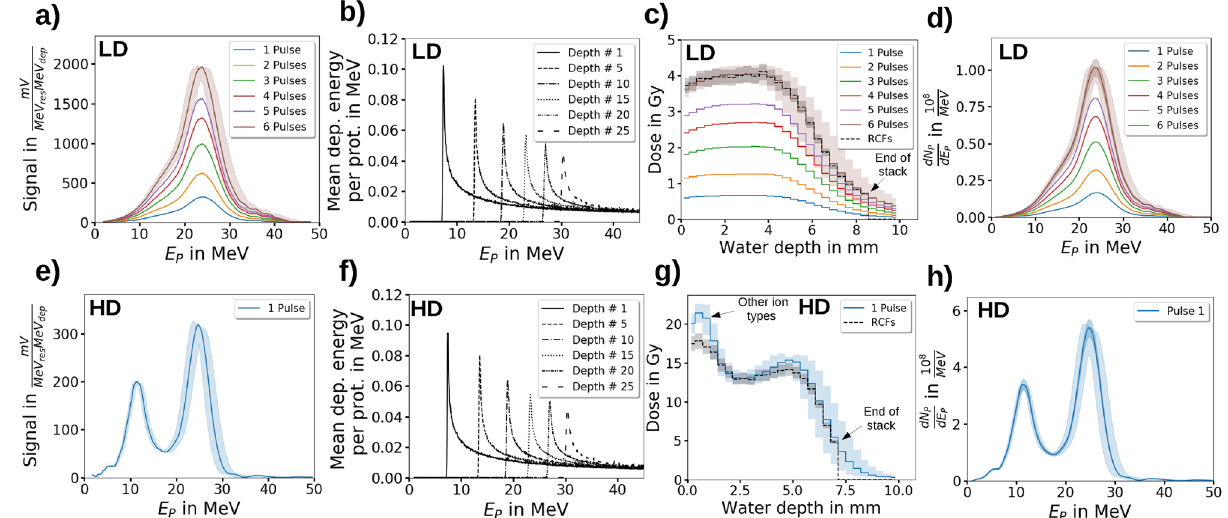
Figure 4. The depth dose distribution prediction from the relative kinetic proton energy spectrum for the calibration of the time-of-flight (ToF) beam monitoring system (BMS). ( a )/( e ) The relative kinetic proton energy spectrum measured with the ToF BMS for the low dose per pulse (LD, accumulated) / high dose per pulse (HD) 5.5% ( 1 σ ) relative energy uncertainty of the operation mode. The energy uncertainty range results from the ± ± ToF BMS. ( b )/( f ) The simulated response matrix for the proton beam propagation from the ToF BMS to the irradiation site and the energy deposition at the irradiation site for the LD/HD operation mode. It provides the kinetic proton energy -resolved mean energy deposition in the defined cylinders in the RCF stack per proton at the ToF scintillator position. The response matrix is used to transfer the measured relative kinetic proton energy spectrum to the relative depth dose distribution at the irradiation site. ( c )/( g ) The depth dose distribution at the irradiation site for the LD (accumulated) / HD operation mode. Normalization of the predicted relative depth dose distribution with the depth dose distribution measured by radiochromic films (RCFs) yields the calibration factor of the ToF BMS for obtaining the calibrated kinetic proton energy spectrum. The dose uncertainty 5.6% ( 2 σ ) of the RCFs. The dose range of the RCFs results from the relative dose calibration uncertainty of ± ± 5.5% ( 1 σ ) uncertainty range of the ToF BMS predicted dose results from the relative energy uncertainty of ± ± 5.6% ( 2 σ ) of the RCFs. d) / g) The calibrated of the ToF BMS and the relative dose calibration uncertainty of ± ± kinetic proton energy spectrum for the LD (accumulated) / HD operation mode. The energy uncertainty range 5.5% ( 1 σ ) relative energy uncertainty of the ToF BMS and the particle number uncertainty results from the ± ± 5.6% ( 2 σ ) of the range results from the relative dose calibration uncertainty of ± ±